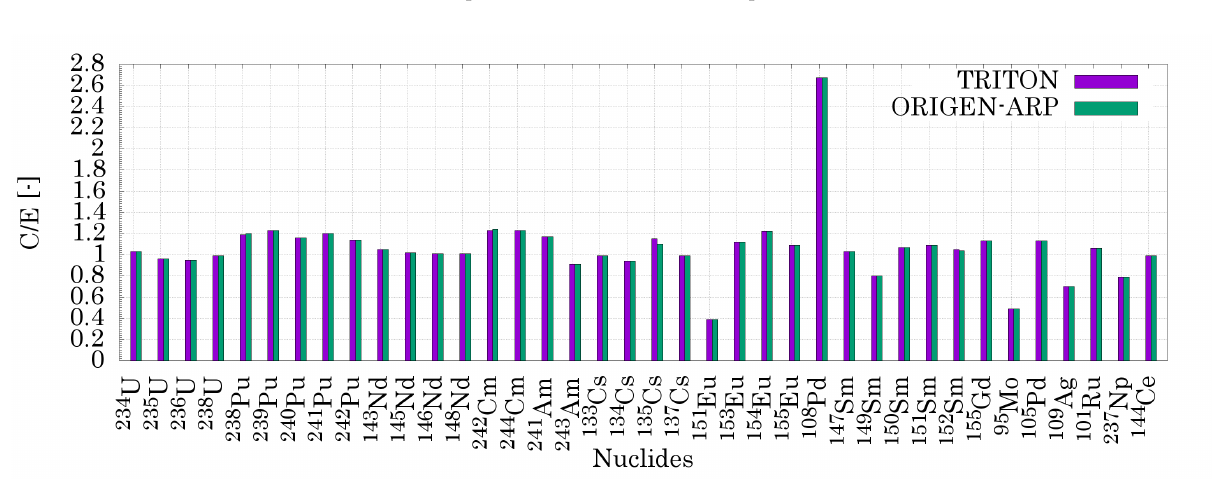
Table 6. Comparison of calculated and experimental data